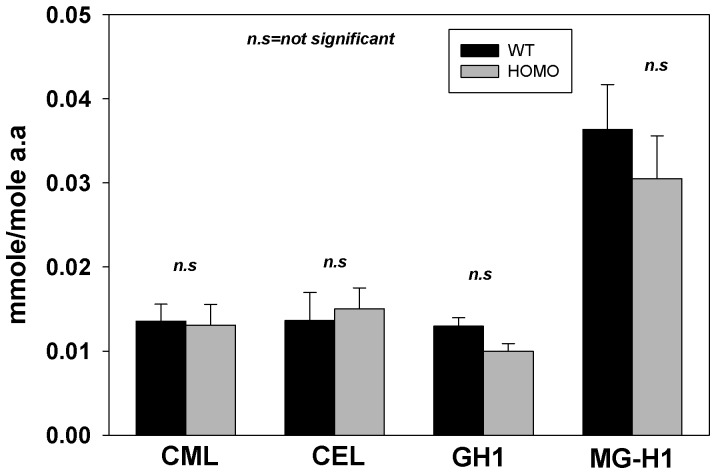
Quantitative comparison of mean levels ± SD for protein modification by glycation at 9 mos old of WT and Homo-LEGSKO mice lenses.Carboxymethyl-lysine (CML), carboxyethyl-lysine (CEL), methylglyoxal hydroimidazolone-1 (MG-H1), and glyoxal hydroimidazolone-1 (G-H1) were determined by LC/MS. No significant (n.s) change was observed between WT and LEGSKO lenses. Student’s t test was used for data analysis.